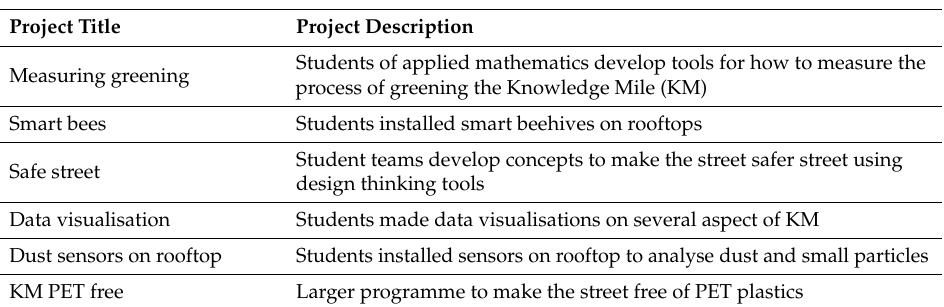
Table 3. Some project